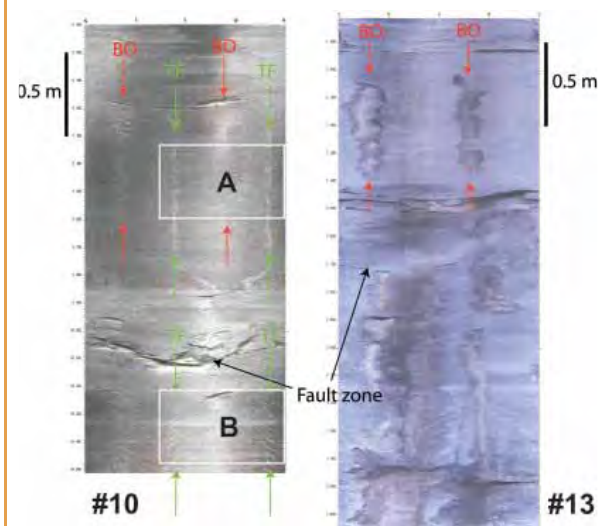
Figure 5. Examples of breakout zones (BO) and drilling induced ten- sile fractures (TF) from boreholes 10 (left) and 13 (right) in earthquake laboratory